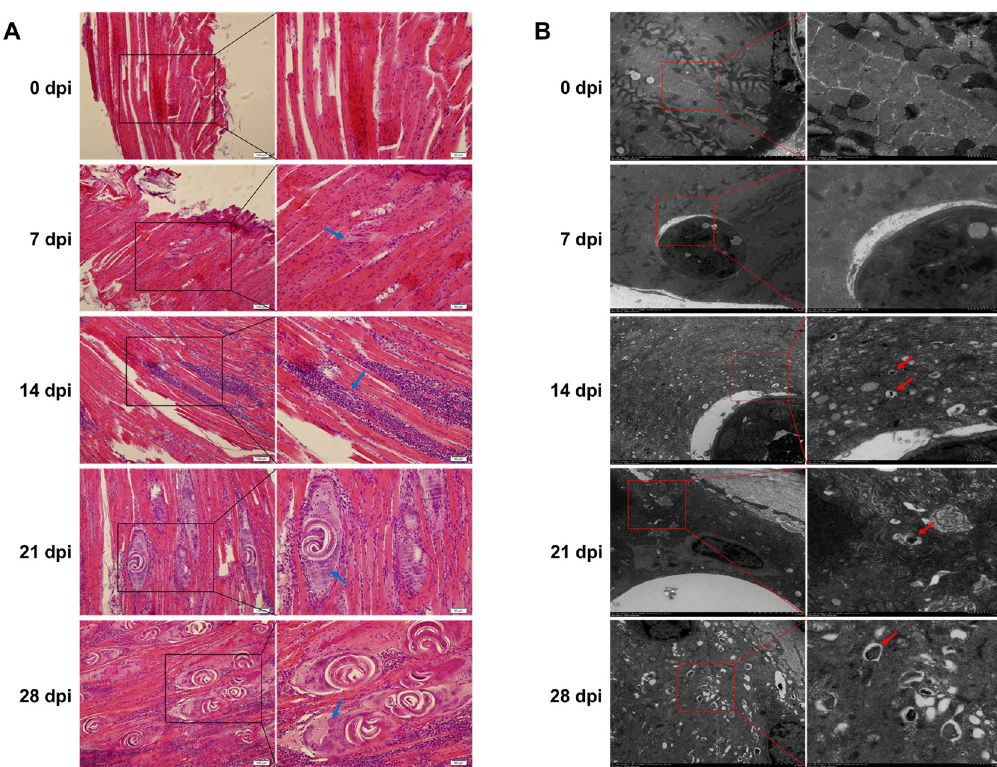
Fig 1. Histopathological changes and formation of autophagic-like vacuoles in T . spiralis -infected mice. A. Sections of murine diaphragms after HE staining on days 0, 7, 14, 21, and 28 post infection observed by fluorescence microscope (magnification, 200 × and 400 × ), The arrows on 7 and 14 dpi: weeny muscle larvae, 21 and 28 dpi: enlarged muscle nuclei. B. TEM images of autophagic-like structures in diaphragms of T . spiralis -infected mice on 0, 7, 14, 21 and 28 dpi (magnification, 1.0k × , and 3.0k × ). Arrows indicate autolysosome-like structures. The images are representative of 3 independent experiments.